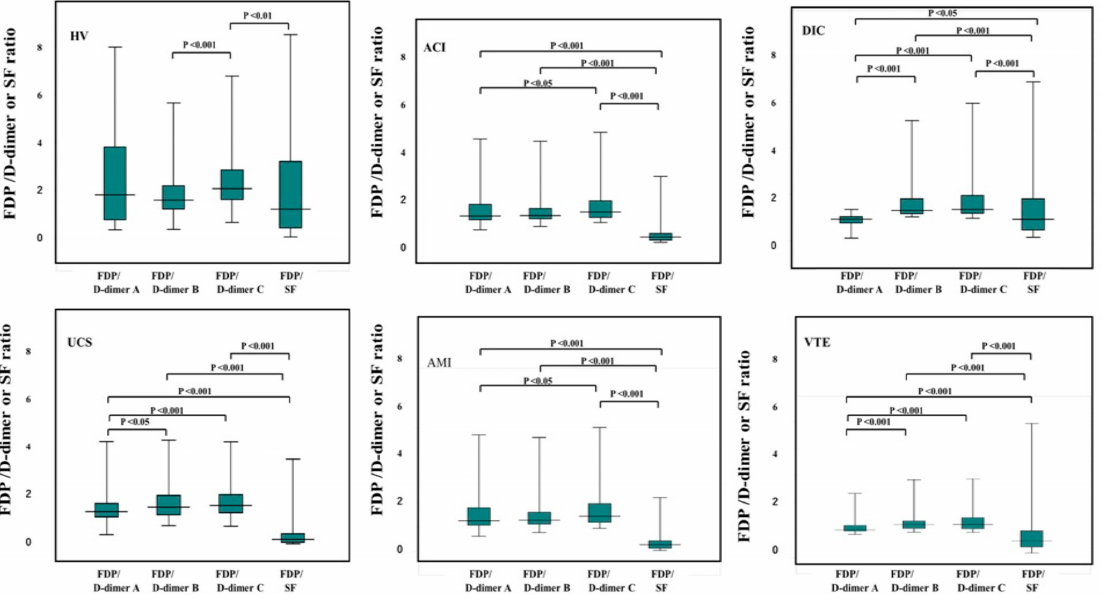
Figure 3. The ratio of FDP/D-dimer or SF in DIC (n = 193), PAVTE (n = 80), AMI (n = 80), ACI (n = 202), UCS (n = 98), and HV (n = 98). DIC, disseminated intravascular coagulation; PAVTE, peripheral arterial and venous thromboembolism, AMI, acute myocardial infarction; ACI, acute cerebral in- farction; UCS, unidenti fi ed clinical syndrome; HV, healthy volunteers; FDP, fi brinogen and fi brin degradation product; SF, soluble fi brin In ACI patients, 99 patients were diagnosed with atherosclerotic or lacunar ACI. Plasma lev- els of FDP and D-dimer A–C were signi fi cantly lower in patients with atherosclerotic or lacunar ACI than in those with other ACI. However, there was no signi fi cant di ff erence in plasma SF levels be- tween two groups (Table 3). Sixty-three ACI patients were previously treated with anti-thrombotic agents, such as anti-platelet agents, warfarin, and direct oral anticoagulants. There was no signi fi - cant di ff erence in plasma levels of SF, FDP, and D-dimer A–C between AIC patients treated with